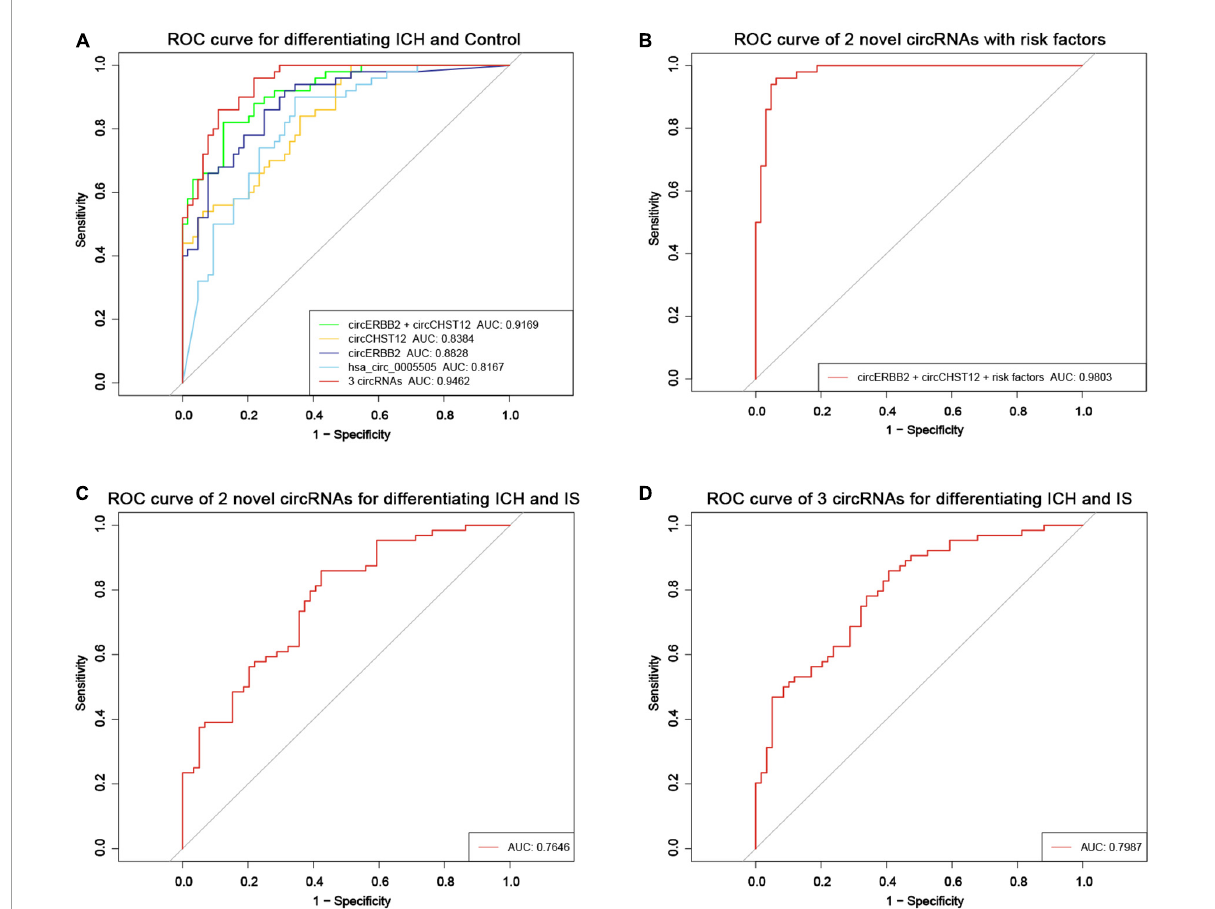
FIGURE7 Evaluation of the circRNA diagnostic value in ICH patients. (A) Receiver operating characteristic (ROC) curves were calculated using the expression levels of circERBB2, circCHST12 and hsa_circ_0005505 for differentiating patients with intracerebral hemorrhage (ICH) and healthy controls ( n = 64 vs. 50). (B) ROC curves of combining circERBB2 and circCHST12 with ICH risk factors to differentiate patients with ICH and healthy controls in all samples ( n = 64 vs. 50). (C) ROC curves of combining circERBB2 and circCHST12 for differentiating patients with ICH and IS patients in all samples ( n = 64 vs. 59). (D) ROC curves of two novel circRNAs, circERBB2 and circCHST12, combined with hsa_circ_0005505 for differentiating patients with ICH and IS patients in all samples ( n = 64 vs.